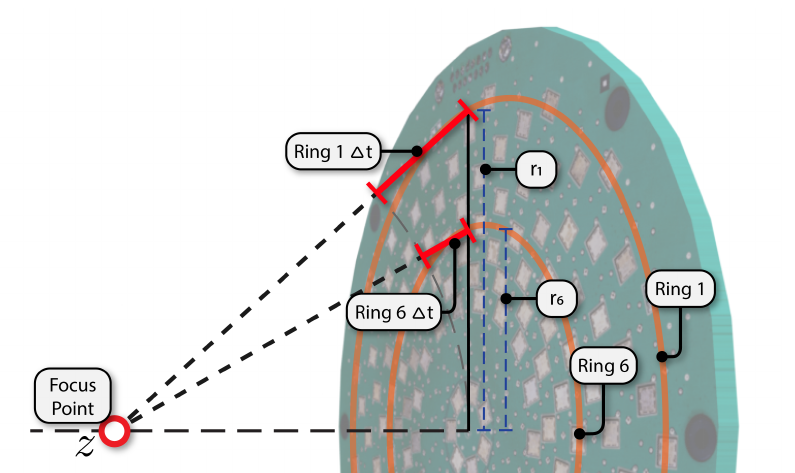
Figure 9. The difference in path length and hence time delay ∆ t is illustrating in this diagram for two of the array rings when focusing in the near-field at a distance z in front of the array.